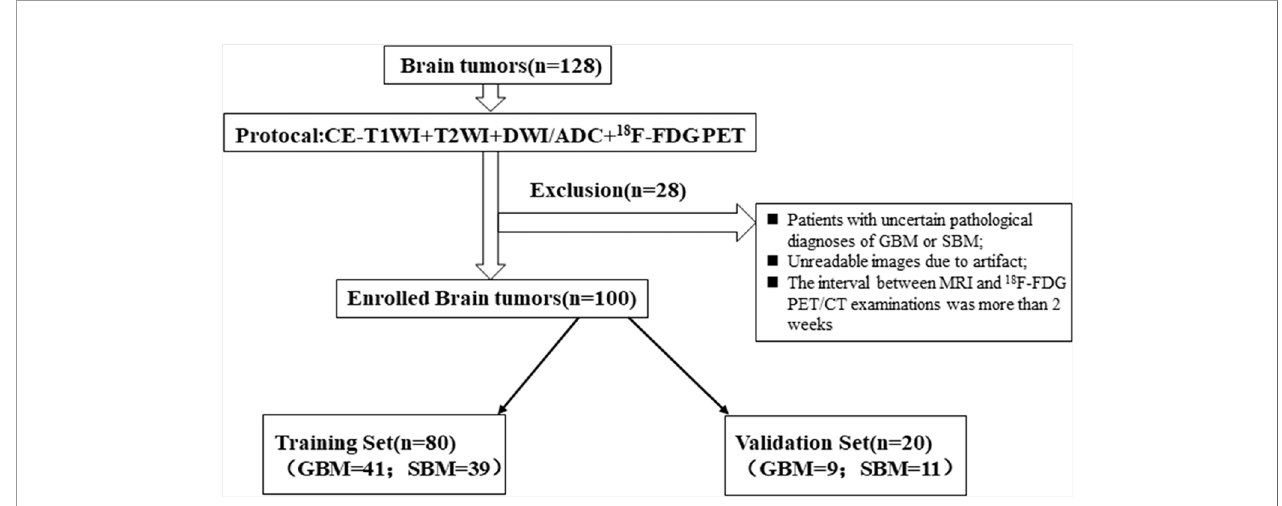
FIGURE 1 | The fl owchart of patient selection